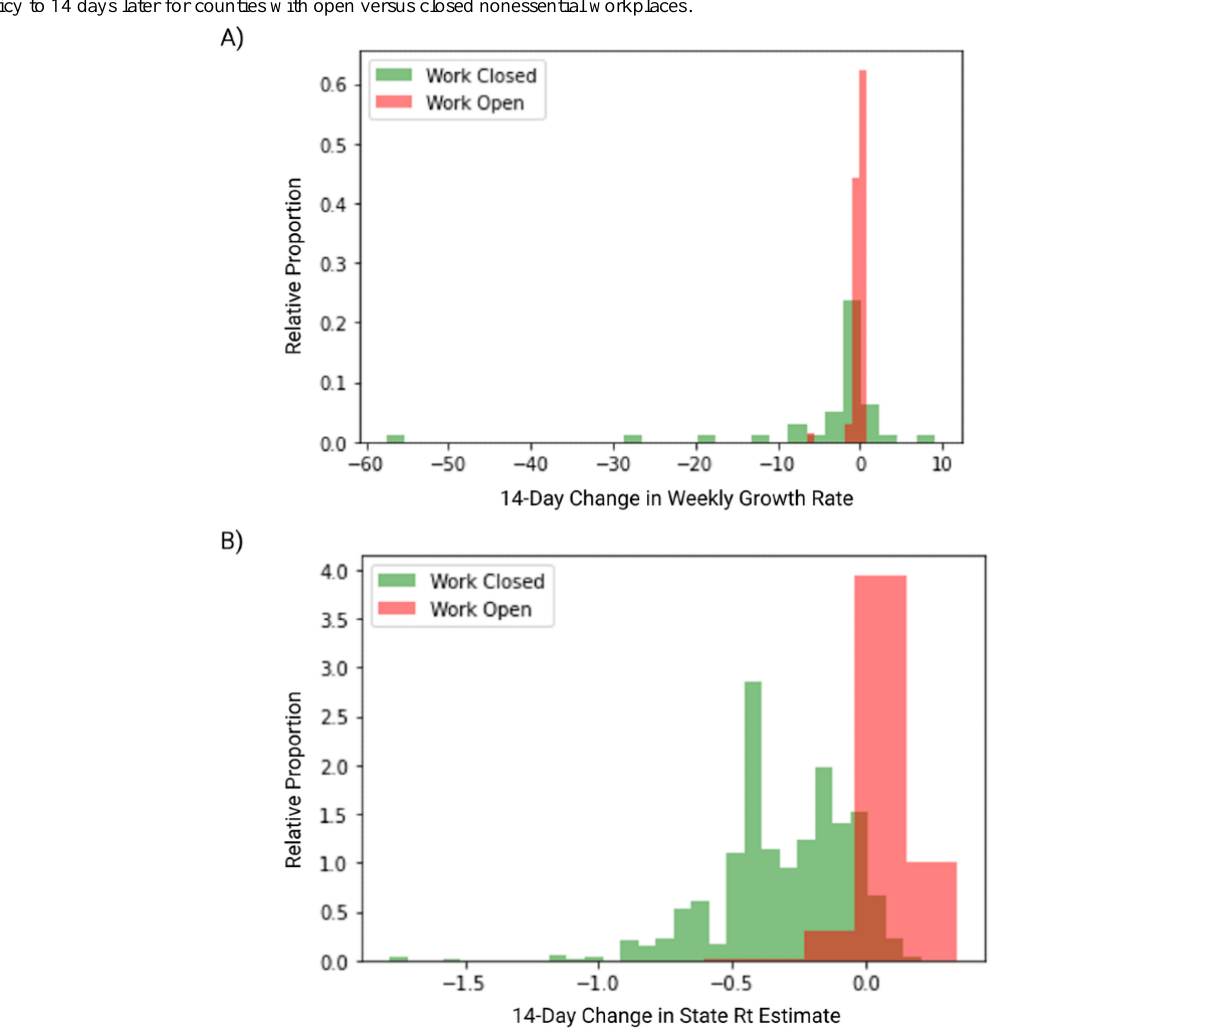
Figure 3. Counties with closed nonessential workplaces and significant declines in growth rate and reproduction number ( R t ) following workplace closure. (A) A histogram of the change in weekly case growth rate from the week preceding the date of workplace closure to 14 days later for counties with open versus closed nonessential workplaces. (B) A histogram of the change in RT Live estimates of R t by state from the date of the workplace policy to 14 days later for counties with open versus closed nonessential